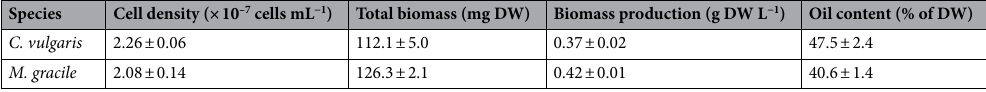
Table 1. Cell density, total biomass and oil content of C. vulgaris and M. gracile harvested at stationary growth phase from 0.3 L cultures. Data shown as the mean ± SD (n = 3).